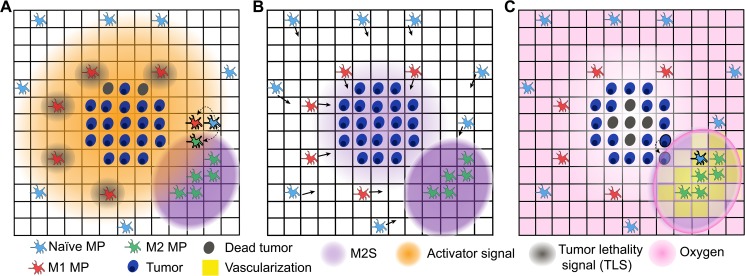
Core features of the early tumor-immune network model.This schematic illustrates key processes captured in the HDC agent-based model. (A) Macrophage polarization and tumor killing. Naïve macrophages (MP) polarize to either an M1 state, in the presence of high levels of Activator signal, or an M2 state, with concomitant exposure to M2 signal (M2S). M1 cells secrete tumor lethality signal (TLS), high levels of which kills tumor cells. (B) Macrophage chemotaxis. All macrophages chemotax along gradients of M2S, which is secreted by the tumor and M2 cells. (C) Vascularization, tumor proliferation, and the effects of oxygen. Oxygen and naïve MP enter at sites of vascularization, which increases as a function of local levels of M2S. All cells die in anoxic conditions, and dead cells are retained (e.g., forming a necrotic tumor core, as depicted). Individual tumor cells divide at a fixed rate, expanding to “invade” neighboring lattice sites.